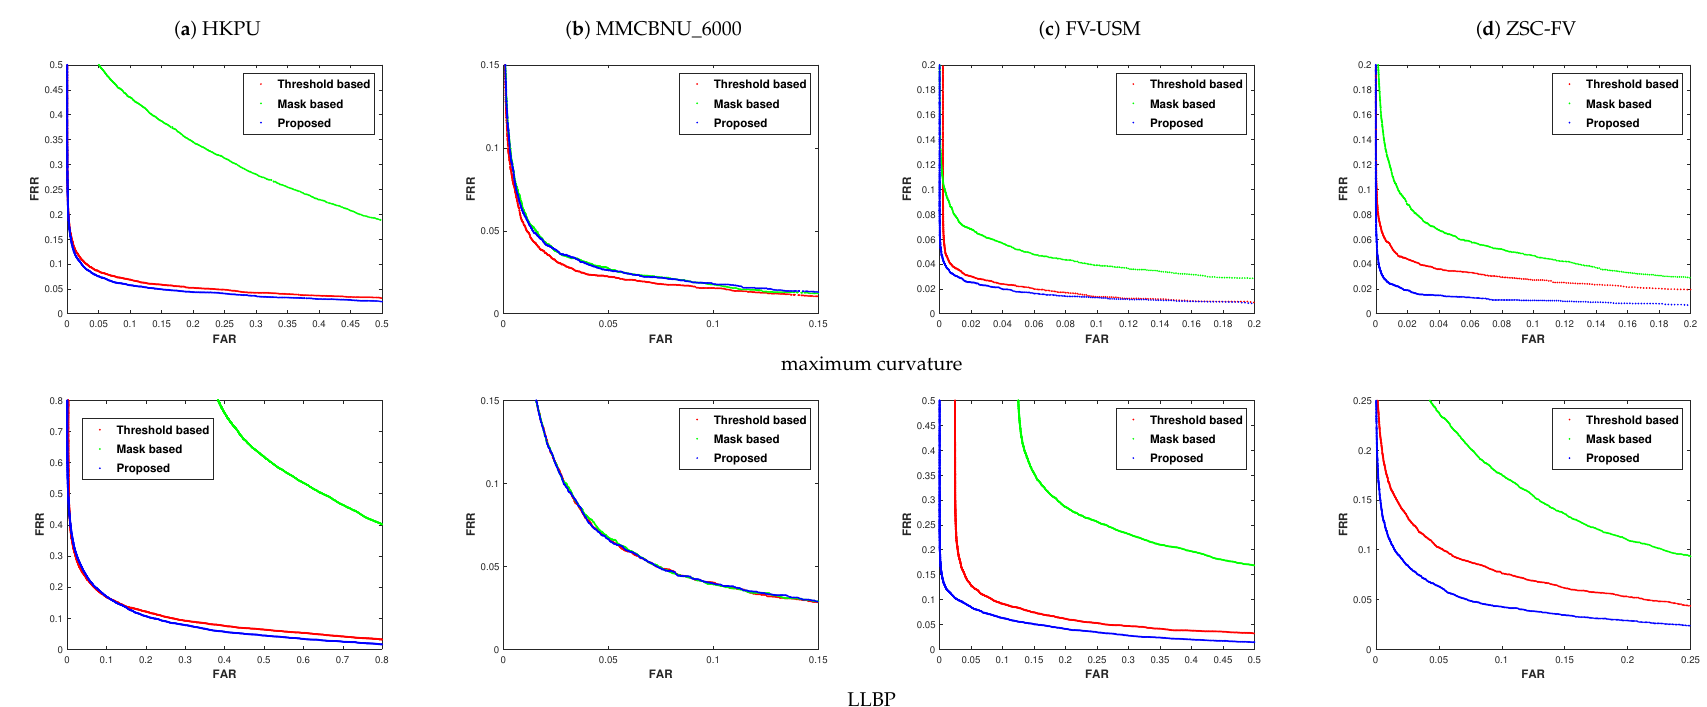
Figure 10. Comparison of the ROC curves of different kinds of ROIs, obtained by using maximum curvature [10] and LLBP [13] features, respectively. ( a ) HKPU, ( b ) MMCBNU_6000, ( c ) FV-USM, and ( d )